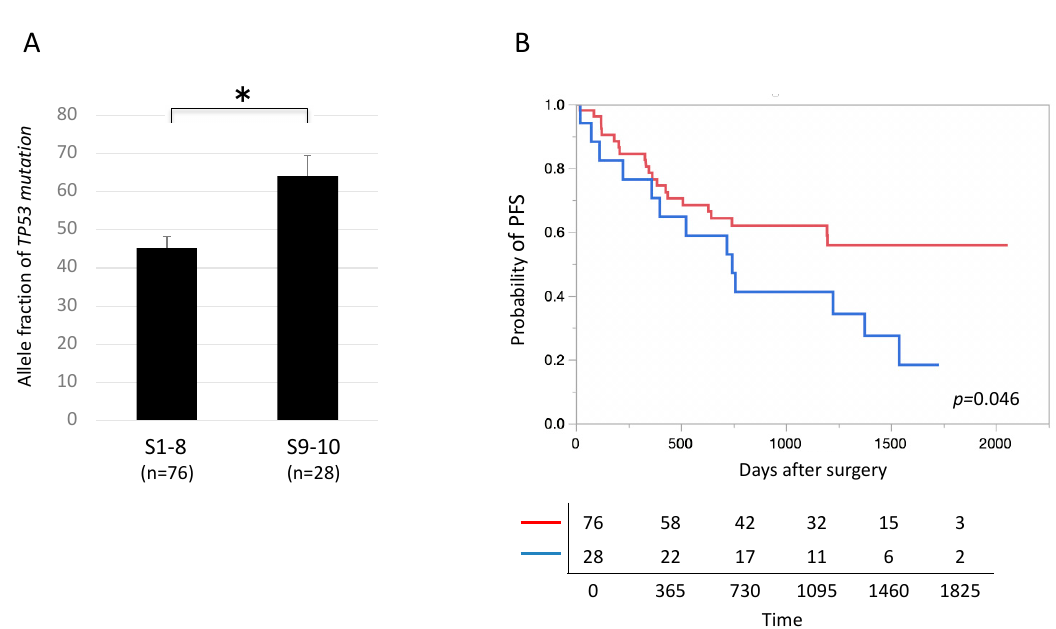
Figure 6. Locational variation in prognosis in lung cancers with TP53 mutations. ( A ) Allele fractions of tumor protein p53 ( TP53 ) mutations were significantly higher in TP53 -mutated lung cancers located in segments 9 and 10 than in those located in segments 1 to 8. * p < 0.05. ( B ) The prognosis was significantly poorer in TP53 -mutated lung cancers located in segments 9 and 10 than in those located in segments 1 to 8. Blue and red lines denote tumors located in segments 9–10 and 1–8 ( n = 28 and 76), respectively.